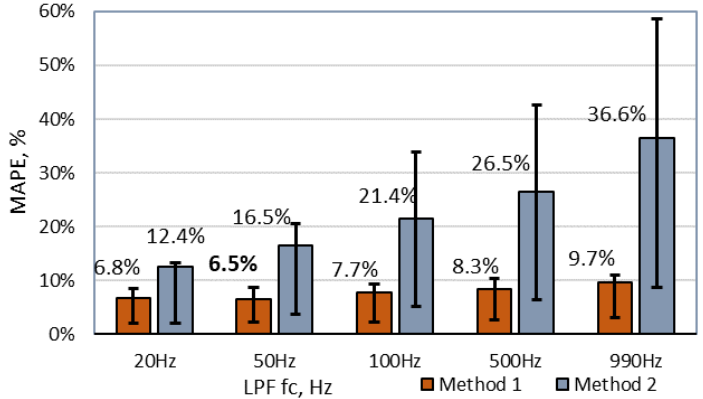
Figure 7. An estimated speed mean absolute percentage error (MAPE) for methods 1 and methods 2 versus applied low-pass filter (LPF) with the particular cut-off frequency with a constant threshold level. Error bars indicate a percentage error range of second and third quartiles. fc, cut-off frequency.